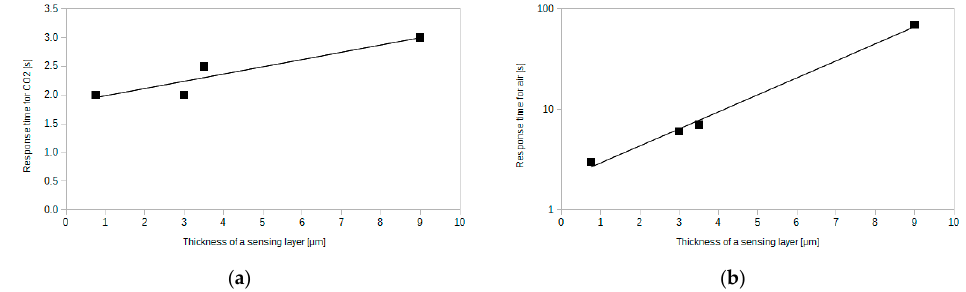
Figure 9. Dependence between the sensing layer thickness and ( a ) response time during exposure to 100% CO 2 ( b ) response time during exposure to air after CO 2 impulse.